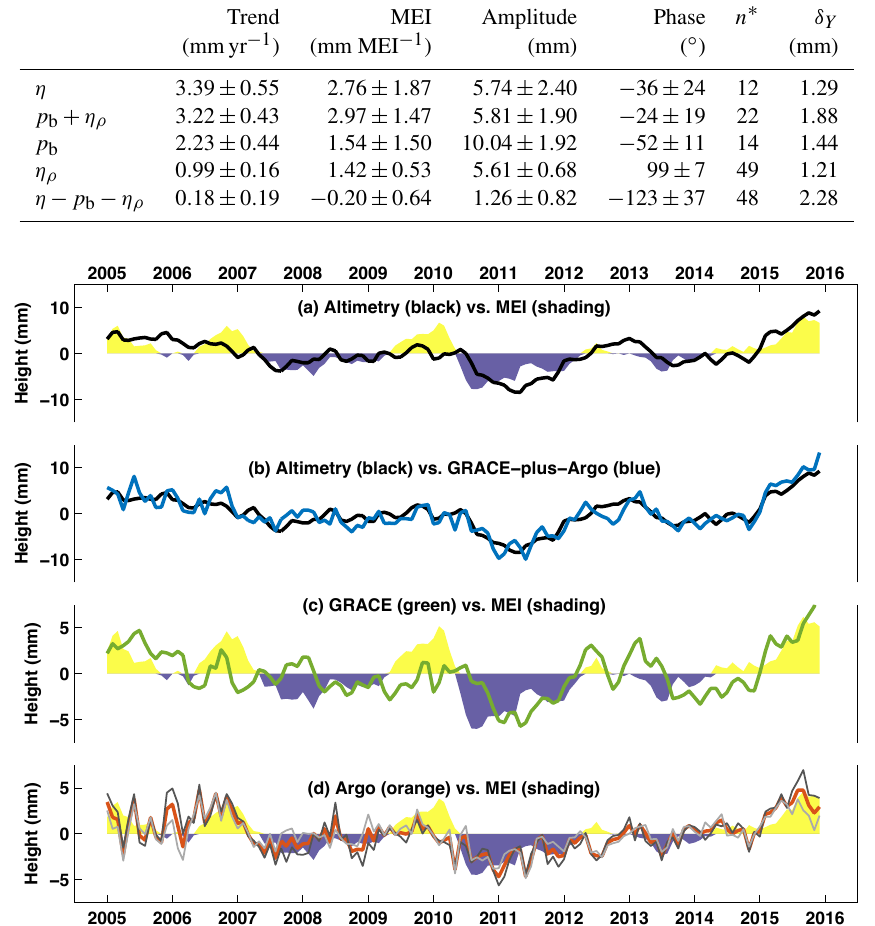
Figure 1. Monthly time series over 2005–2015 of (a) altimetric GMSL (black) and the MEI (shading), (b) GMSL from altimetry (black) and from GRACE and Argo (blue), (c) GRACE barystatic sea level (green) and the MEI (shading), and (d) Argo steric sea level (orange) and the MEI (shading). The thin dark gray (light gray) curve in (d) is Argo steric sea level based on the SIO (IPRC) gridded dataset. Linear trends and annual cycles have been removed from all time series. The MEI record has been scaled to have variance equal to that of the respective sea level time